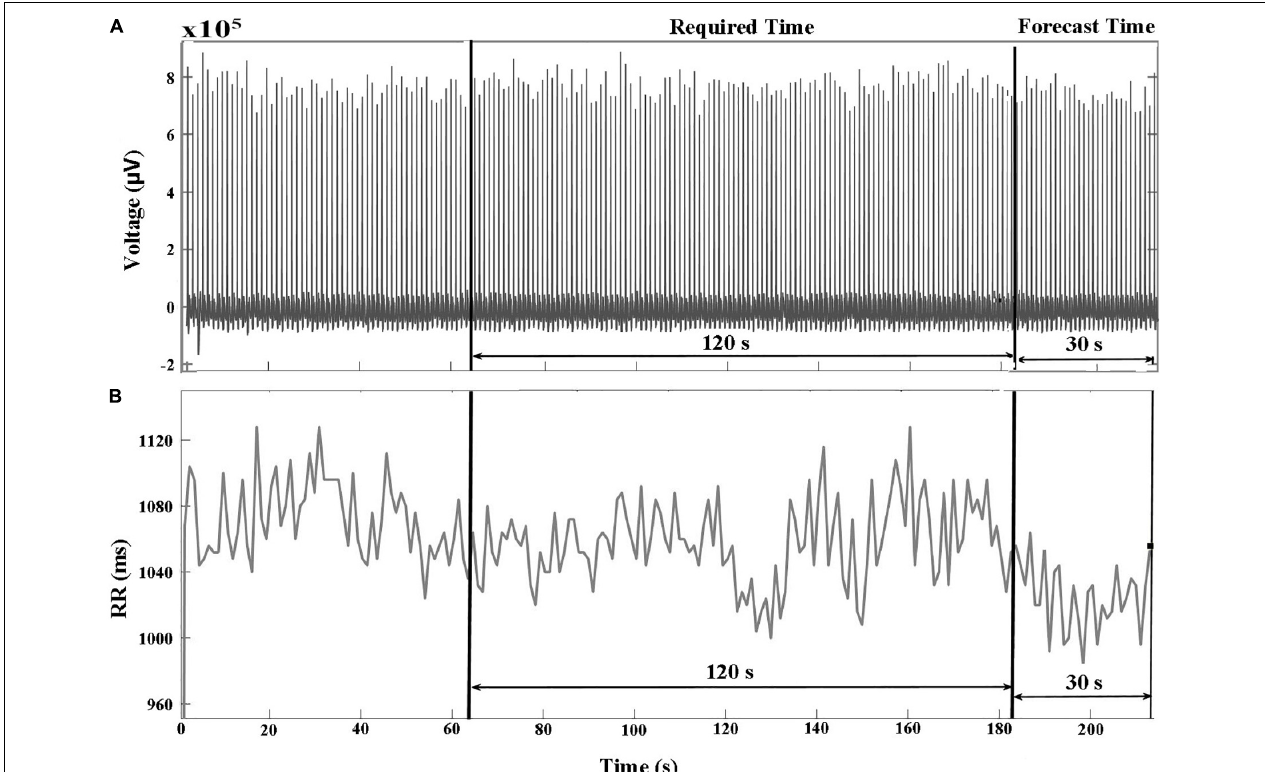
FIGURE 1 | (A) ECG and (B) HRV signals of a VF subject that include two pre-VF regions. The signal 30 s before the VF onset is called the forecast time and the signal 120 s before the forecast time is called as required time. RR represents R-peak to R-peak interval in milliseconds